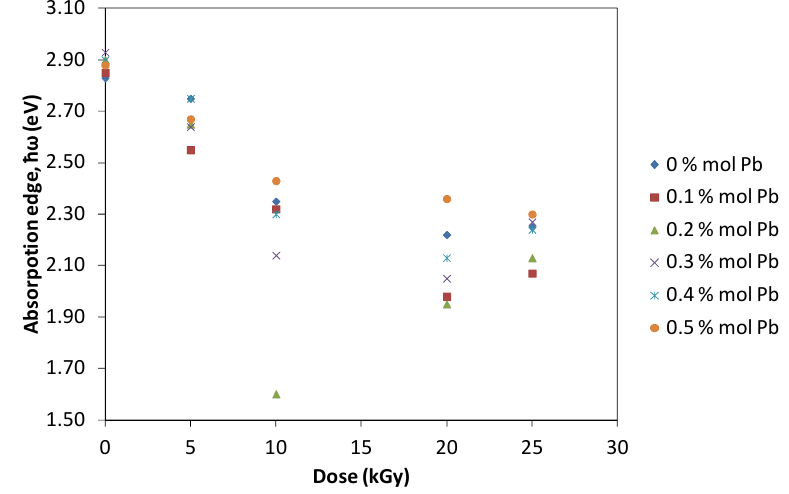
Figure 5. The dependence of Urbach’s absorption edge on different irradiation dose